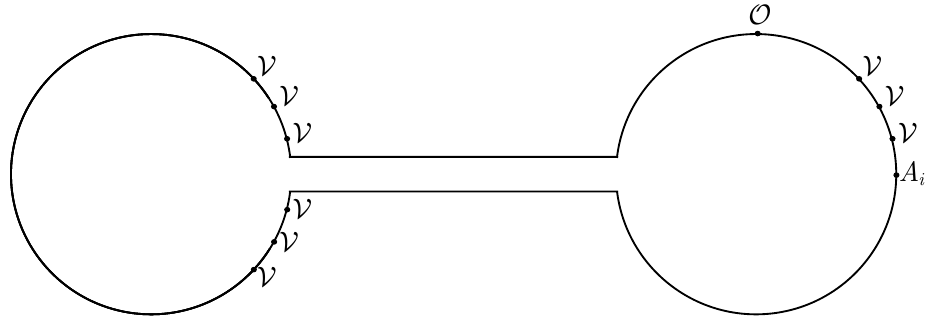
Figure 1. A contribution to the boundary of the moduli space giving a correction to the BRST op- erator. In the region where the boundary operators are close to A i the disc is equivalent to two discs connected by a narrow neck. Through this, a new local operator is de(cid:12)ned inserted in the left disc. Its coe(cid:14)cients with respect to the basis is the expectation value of the right disc. Here V = b (cid:0) 1 O